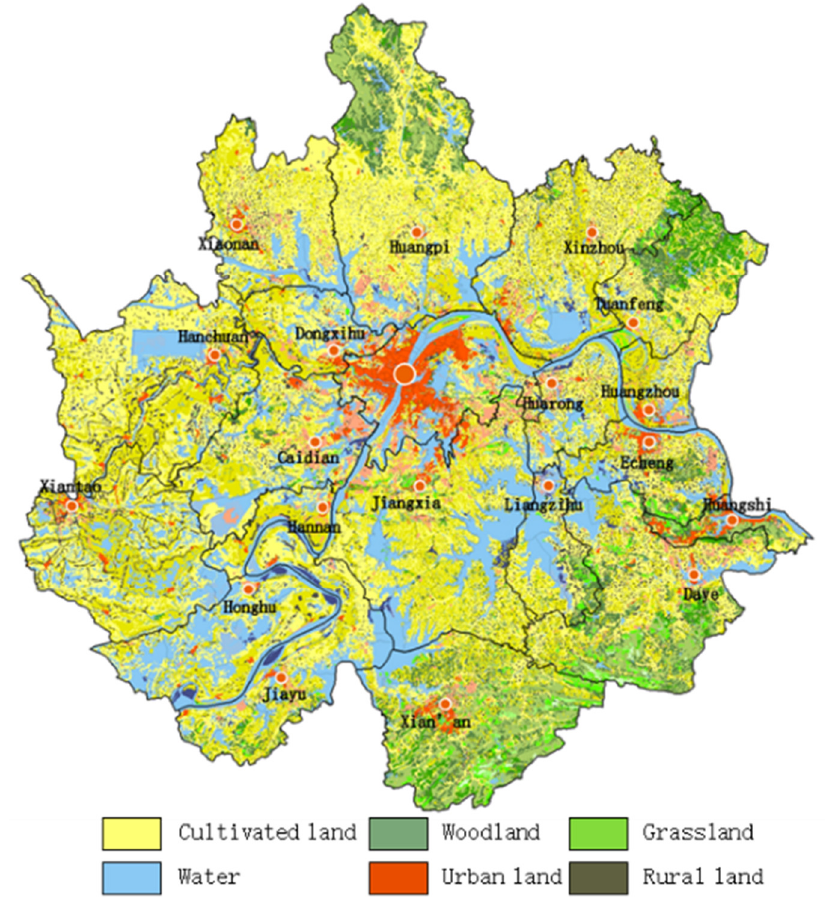
Figure 4. Current situation of land use in the Wuhan metropolitan area.